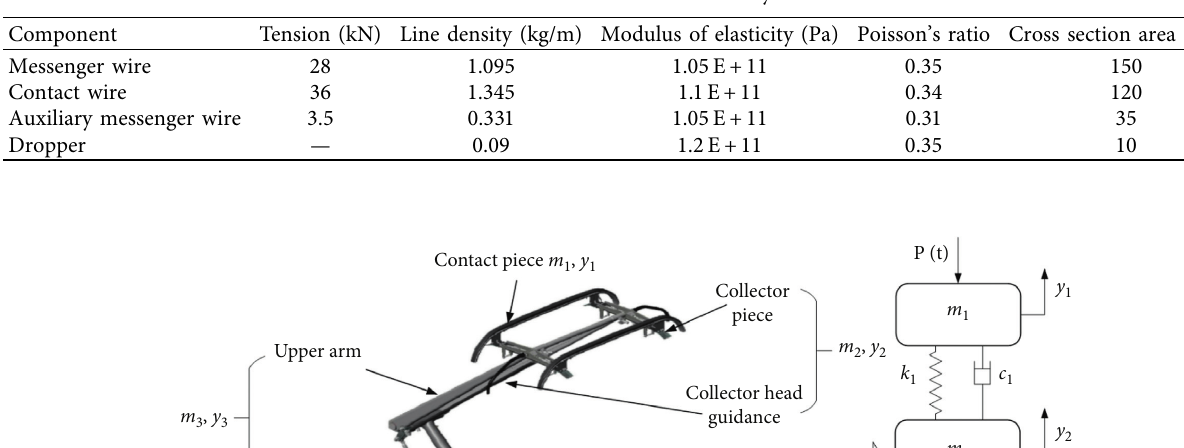
Table 1: Parameters of